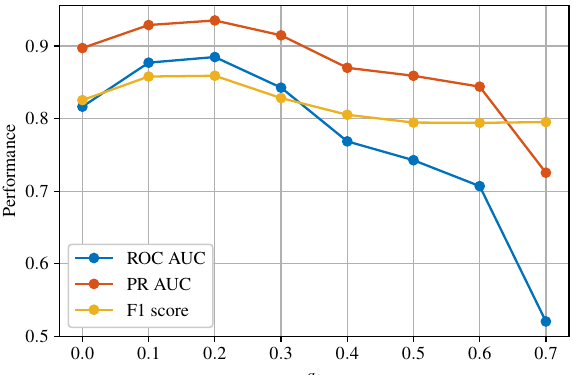
Figure 3. Performance comparison of SSAE models for different values of a 0 .